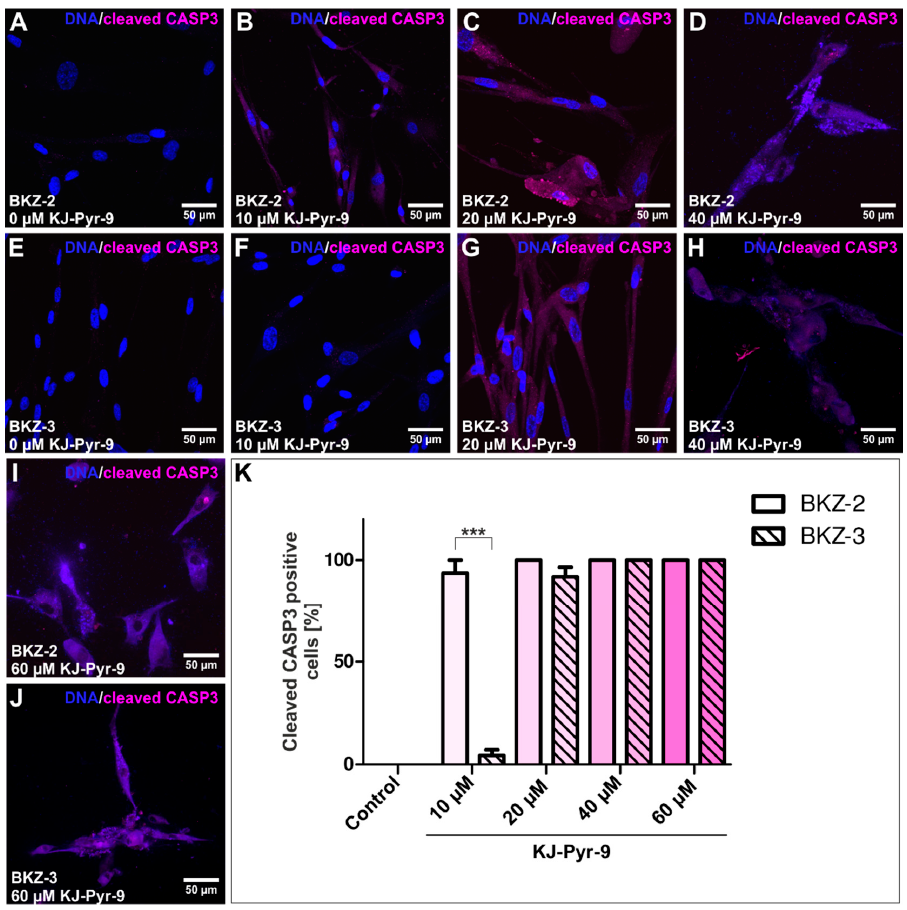
Figure 12. Myc proto-oncogene (MYC)/N-myc proto-oncogene (NMYC) inhibitor KJ-Pyr-9 induces apoptosis of BKZ-2 and BKZ-3. Representative images of immunocytochemical staining for cleaved caspase 3 (CASP3) after KJ-Pyr-9-treatment of ( A–E ) BKZ-2 and ( F–J ) BKZ-3. ( K ) Quantification of the percentage of cleaved CASP3 positive cells after the addition of 10 μ M KJ-Pyr-9 revealed a significantly higher amount for BKZ-2 with about 94% in comparison to BKZ-3 with about 4%. However, concentrations higher than 40 μ M lead to 100% cleaved CASP3 positive cells for BKZ-2 and BKZ-3. Student’s t -test ( p ≤ 0.05). n = 3, *** p ≤ 0.001. Mean ± SEM (standard error of the mean).